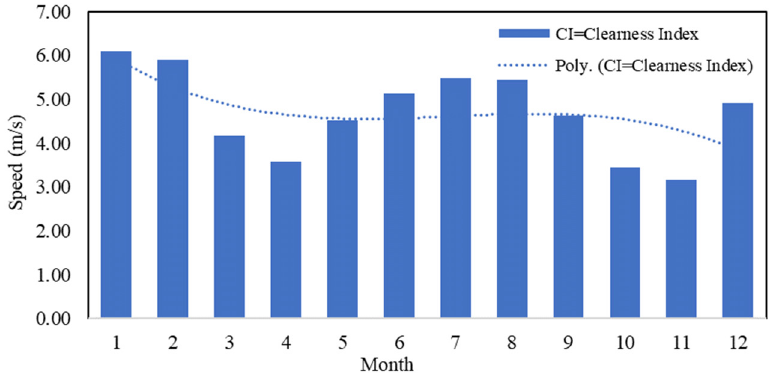
Figure 13. Wind velocity distribution in Karimunjawa Island with a variety of elevations based on global wind altas web- site ( a ) 10 m; ( b ) 50 m; ( c ) 100 m.